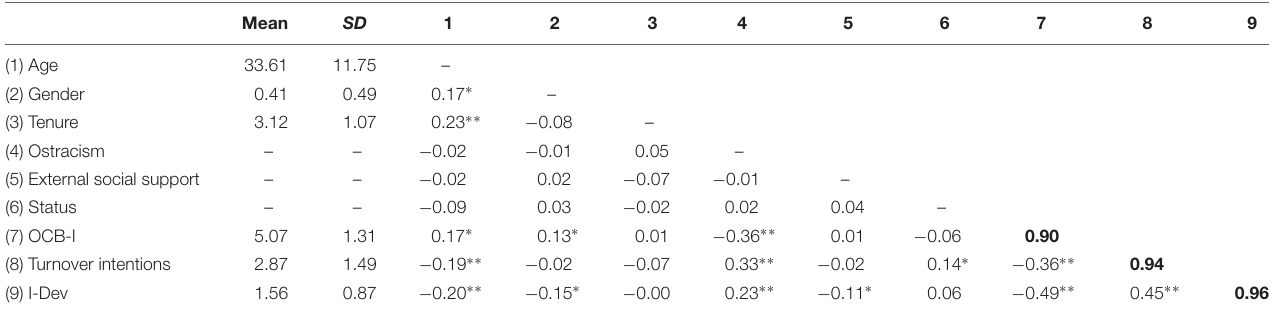
TABLE 2 | Study 1: Descriptive statistics, zero-order correlations, and alphas.